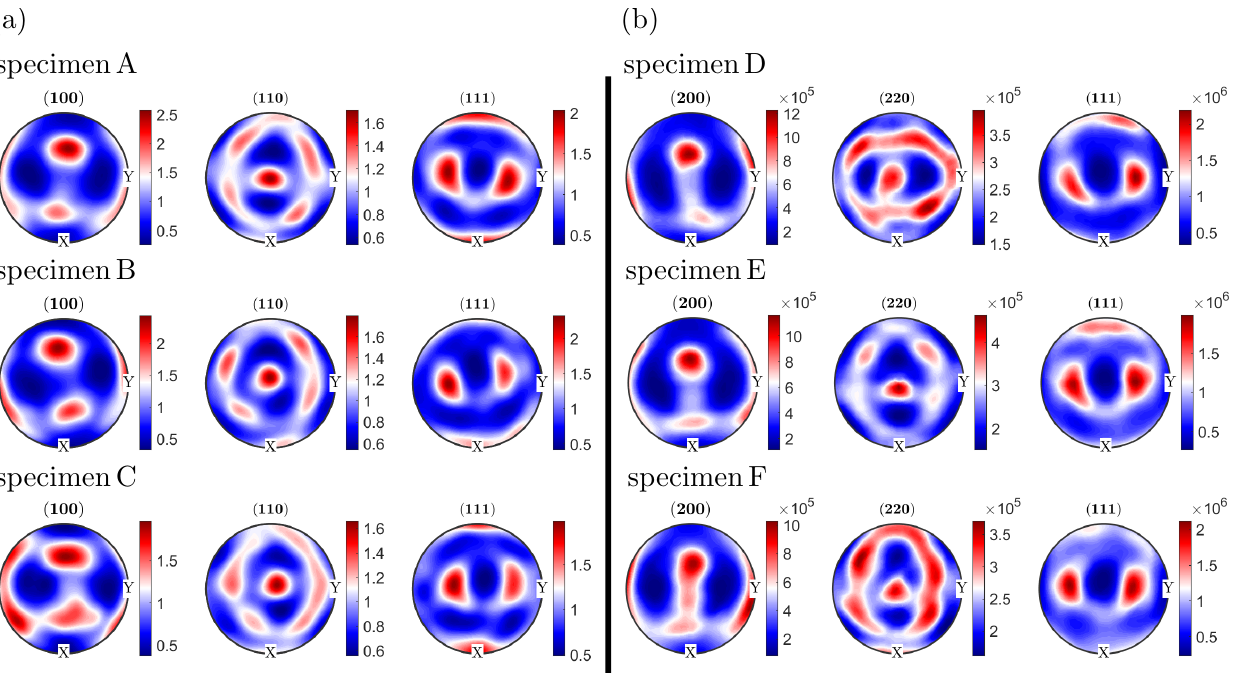
Figure 8. ( a ) Pole figures of specimens A–C, determined by EBSD from measurement areas of 4mm 2 . ( b ) Pole figures of specimens D–F, determined by